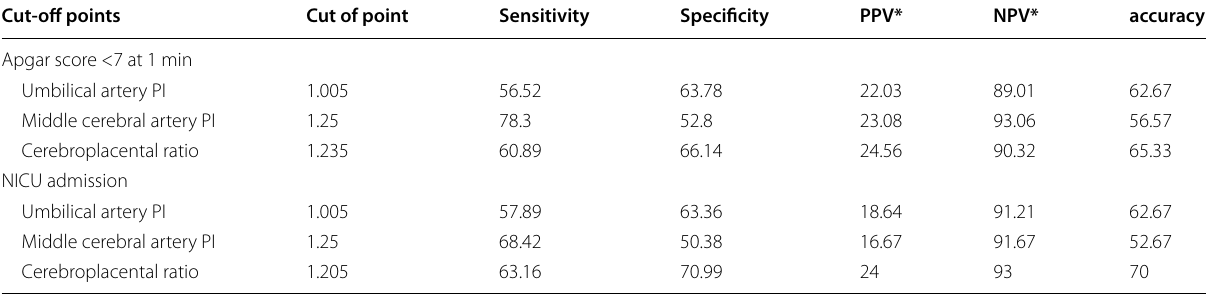
PI pulsatility index, CS cesarean section, IFC intrapartum fetal compromise